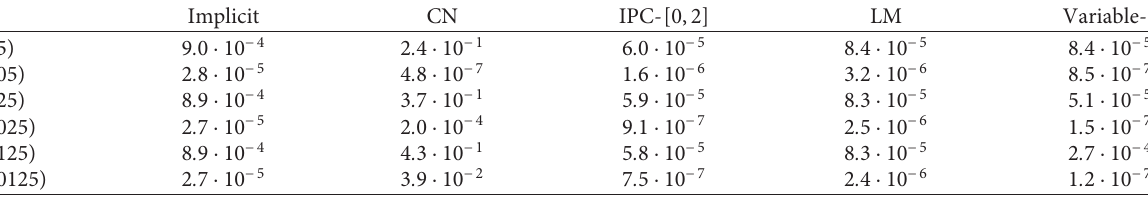
Table 1: L ∞ -error E